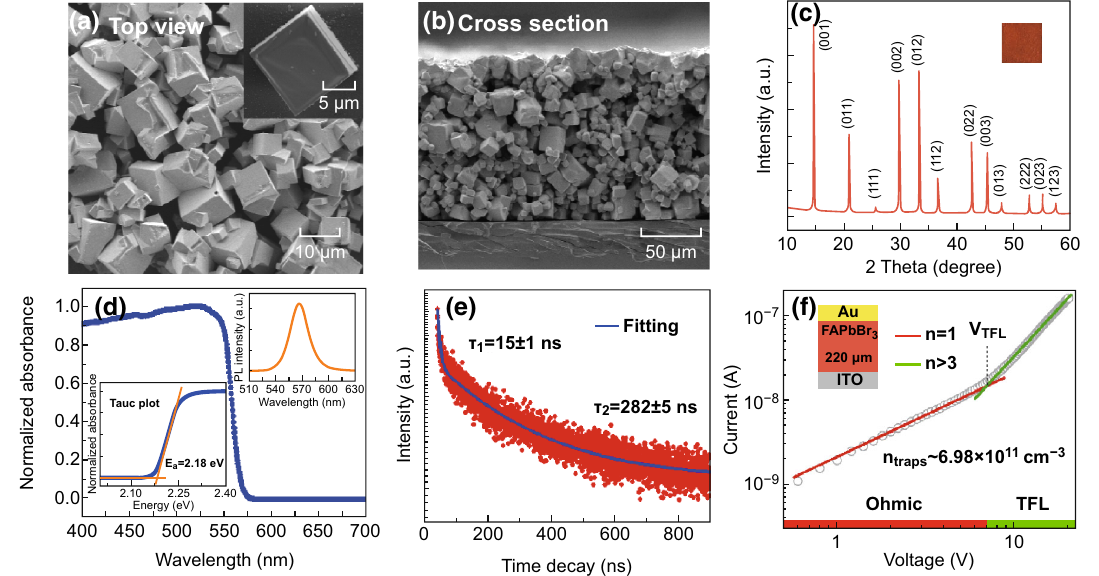
Fig. 1 a Top-view and b cross-sectional SEM images. c XRD pattern d Steady-state absorption spectrum of FAPbBr 3 MCs film. Left insets: the optical bandgap extracted from Tauc plot; right insets: PL spectrum. e PL decay of the sample excited at 376 nm, which could be well fitted by biexponential functions. f Current–voltage responses of FAPbBr 3